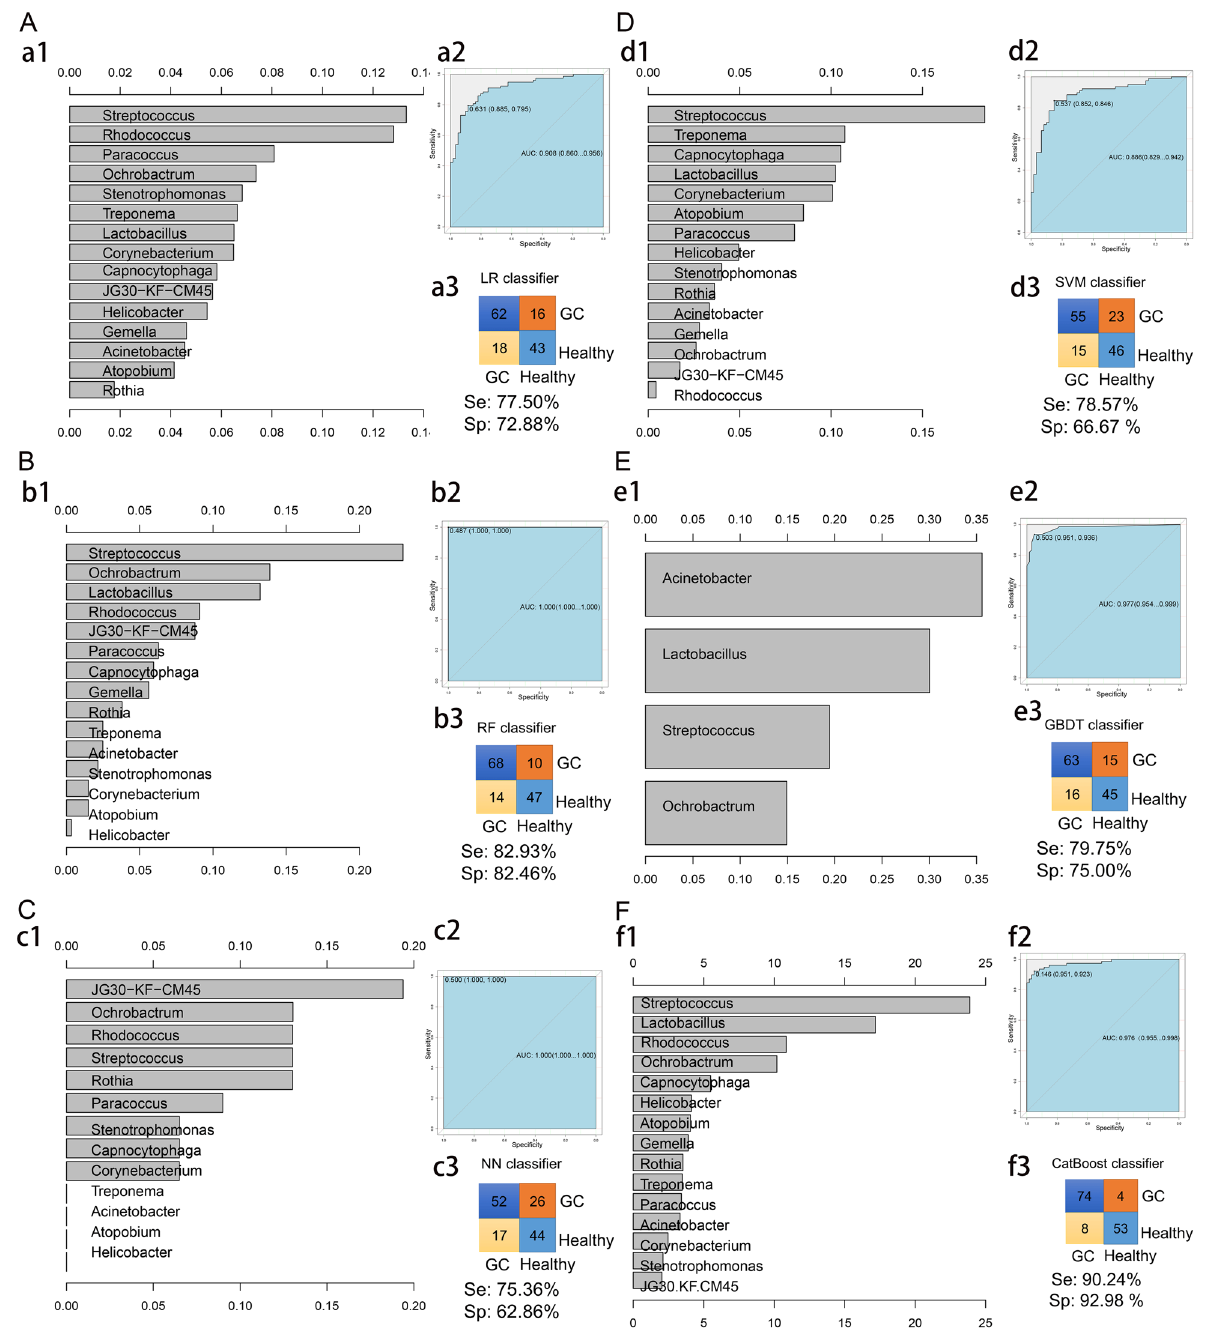
Fig. 4 Graph of the GC risk prediction model. Six models were constructed using the top 30 most abundant bacteria. We used the relevant functions in the rminer Package (version 1.4.5) of R language for modeling analysis and used the fit function for modeling the variable importance calculation. A–F are the LR model ( A ), RF model ( B ), NN model ( C ), SVM model ( D ), GBDT model ( E ) and CatBoost model ( F ). The left panel (a1, b1, c1, d1, e1, f1) show the variable importance histogram of the model, the upper right panel (a2, b2, c2, d2, e2, f2) show the AUC curve of the model, and the lower right panel (a3, b3, c3, d3, e3, f3) show the accuracy of the